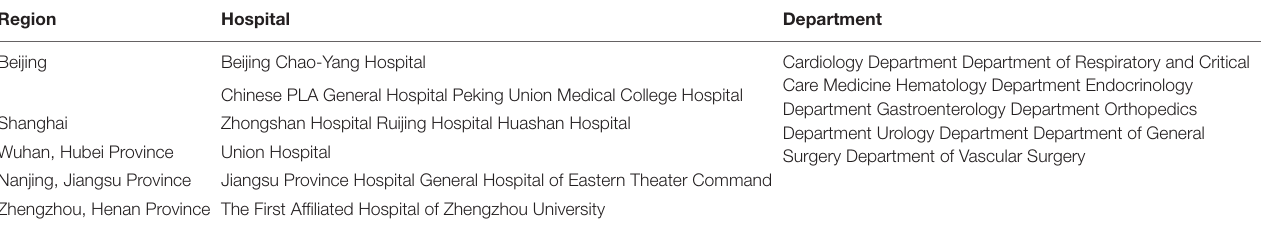
TABLE 2 | Examples of online comment’s sentiment tendency